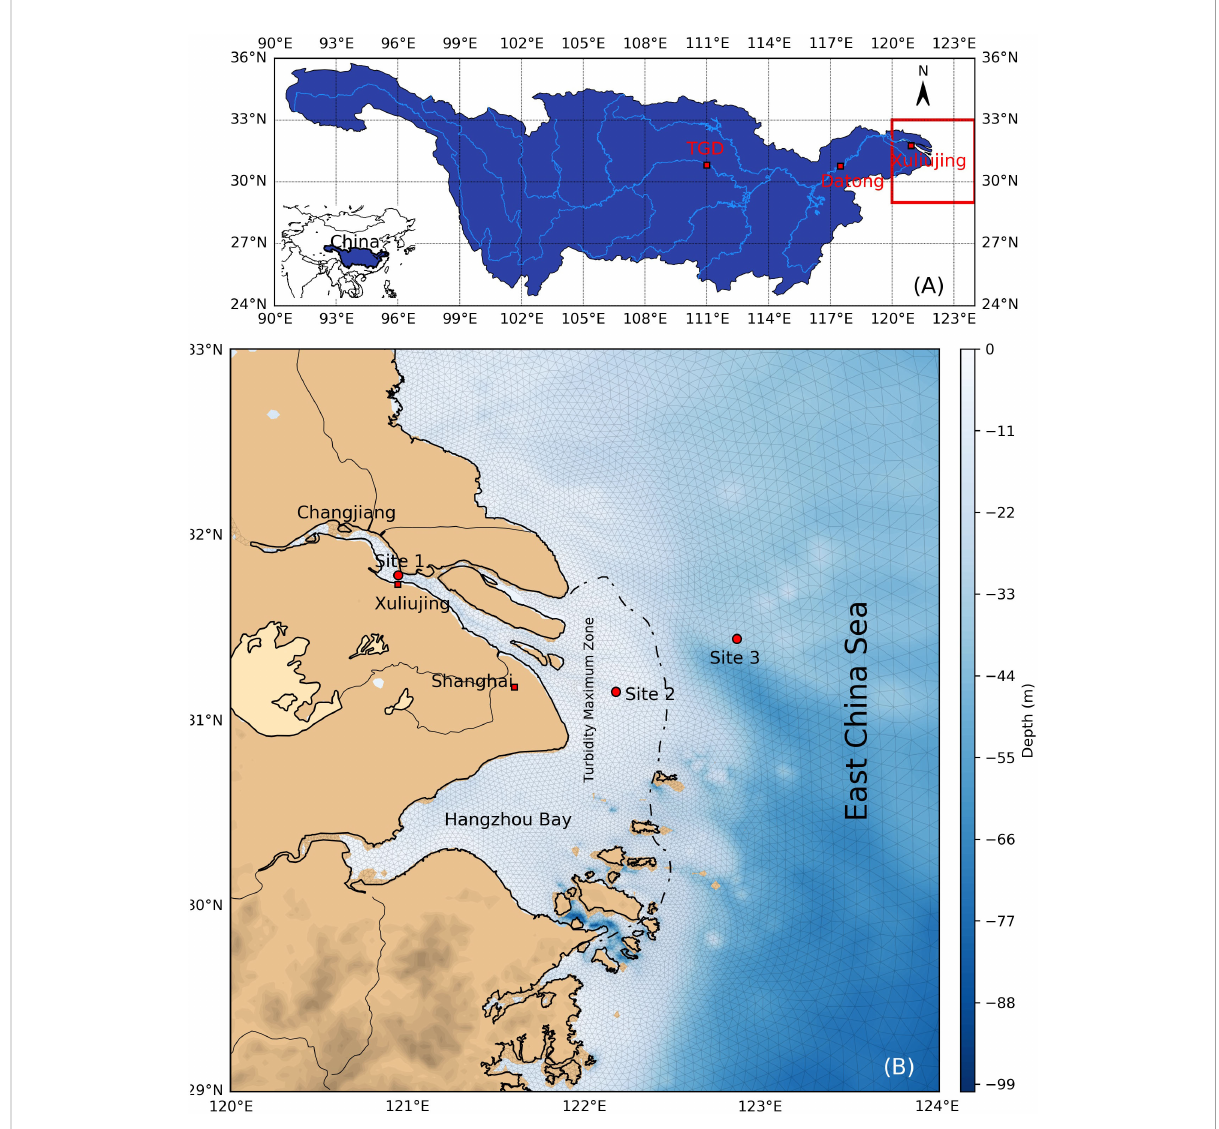
FIGURE 1 Diagram of the study area [modi fi ed from Ge et al. (2020a)] (A) Location of the Changjiang Basin, the Three Gorges Dam (TGD), Datong Station, and Xuliujing Station. (B) Changjiang Estuary and inner shelf of East China Sea. Site 1 (at the river channel), site 2 (at the river mouth), and site 3 (at the inner shelf) are typical sites that were chosen (red dots). The dashed line denotes the boundary of the turbidity maximum